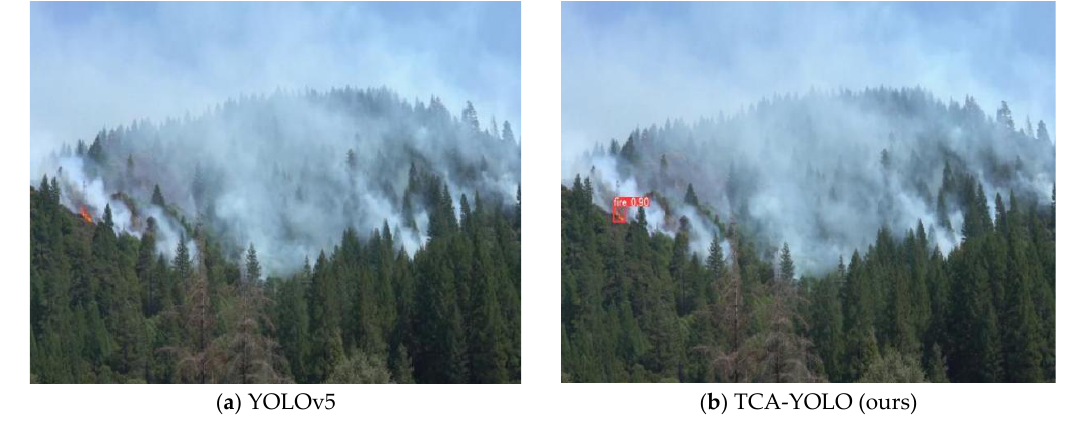
Figure 13. Comparison of small target forest fire detection.(a) YOLOv5 fails to detect the small target forest fire at a distance. (b) Our model can detect the distant small target forest fire.